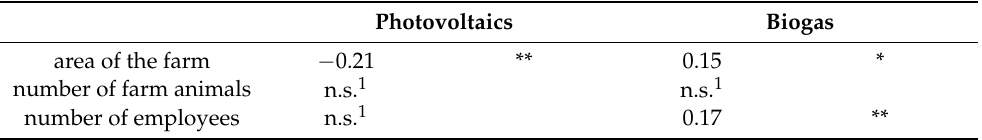
Table 6. Spearman rank correlation for interest in PV and biogas plants and variables regarding the size of the farm. * p < 0.05; ** p < 0.01. Photovoltaics Biogas area of the farm − 0.21 ** 0.15 * number of farm animals n.s. 1 n.s. 1 number of employees n.s. 1 0.17 **